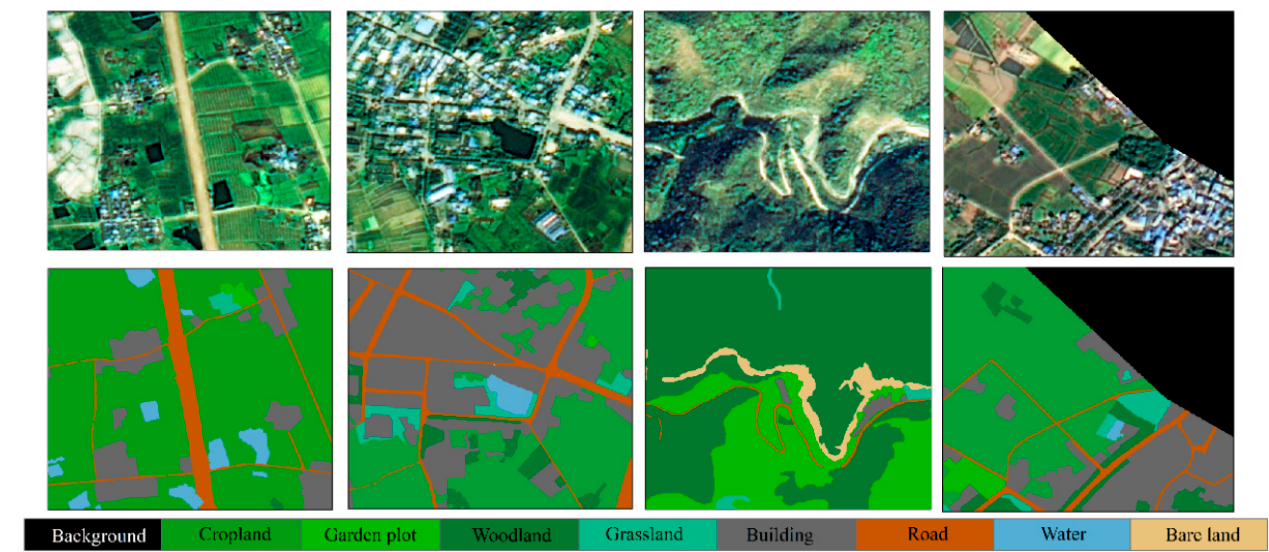
Figure 5. Some typical sample images of MZData and their corresponding labels. LandCover.ai